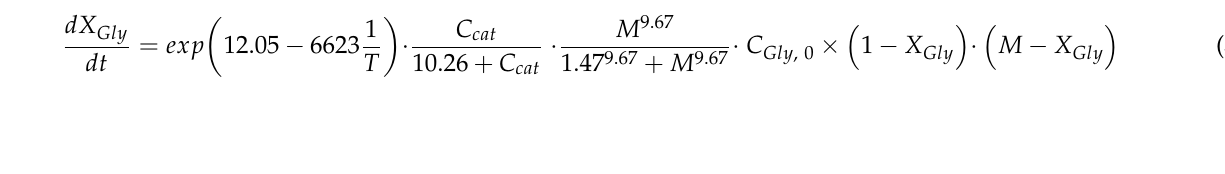
Figure 7. Glycerol conversion (X Gly ) in the transesterification reaction of glycerol with ethylene carbonate catalyzed by zinc stearate under different conditions. Dots represent experimental data, while lines represent the trend in the model for each piece of experimental data. ( A ) Effect of catalyst loading at 80 °C with a CE/Gly ratio of 2. Gly conversion as a function of reaction time with different catalyst loadings, where ◼ represents 1% catalyst loading, ⚫ 3% catalyst loading, and 5% catalyst loading. ( B ) Effect of the initial molar ratio of reactants at 80 °C with 3% catalyst loading. Gly conversion as a function of reaction time with the CE/Gly ratio, where ◼ represents 1.5; ⚫ 2; 2.5; and 3.